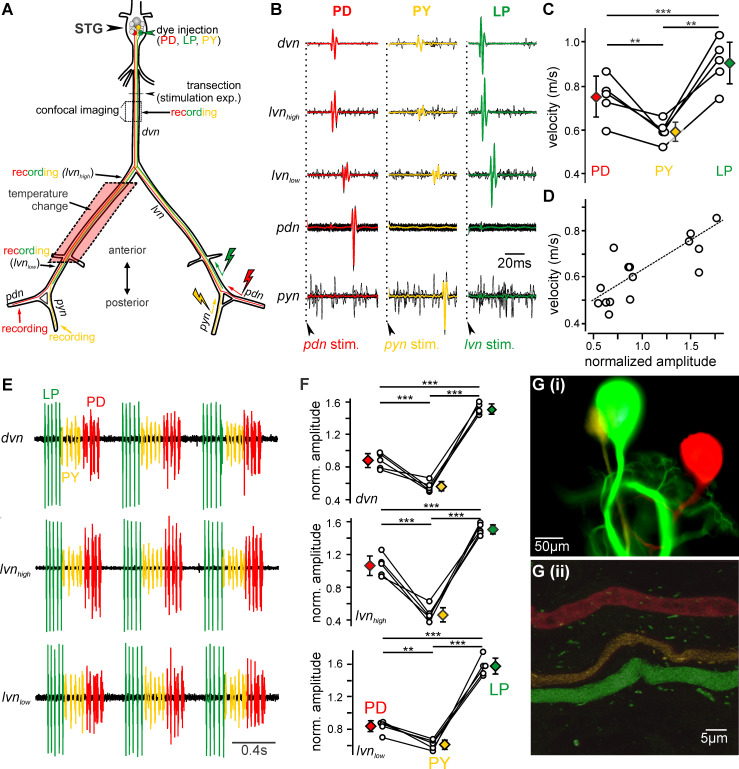
Pyloric axons propagate APs at different velocities.(A) Schematic of the stomatogastric nervous system. Nerve names are italicized. The somata and axons of the PD (red), LP (green), and PY (yellow) neurons are depicted in the color with which they were iontophoretically injected. The dotted box indicates where they were imaged. In some experiments, the dvn was transected, and antidromic APs were elicited in PD, LP, and PY neurons through selective stimulation of the pdn, lvn, or pyn, respectively, on one side of the nervous system (stimulation arrows) and propagated APs were recorded contralaterally. Colors indicate which neurons were detected on a given recording. In selected experiments, temperature was manipulated on parts of the lvn by bathing the nerve in temperature-controlled saline (red box). Nerves: dvn, dorsal ventricular nerve; lvn, lateral ventricular nerve; pdn, pyloric dilator nerve; pyn, pyloric constrictor nerve. (B) Overlay and average of multiple PD, PY and LP APs propagating after stimulation of the pdn, pyn, or lvn (as shown in A), confirming selective activation of individual APs in only one axon at a time. (C) At the control temperature (10°C), the pyloric axons propagate APs at significantly different velocities. (D) Propagation velocity correlates with normalized lvnlow extracellular waveform amplitude. Amplitudes were normalized as in F. (E) Example recordings of three cycles of the pyloric rhythm from multiple locations along the dvn and lvn (compare to A) show that the extracellular AP waveform amplitudes consistently differed between neuron types. (F) Extracellular waveform amplitudes were normalized to the average amplitude of all three neurons in each experiment for comparison across animals. The normalized waveform amplitudes differed significantly from one another at all three locations. Open circles represent the waveform amplitude from a single animal. Colored diamonds represent the average for each neuron type. ** p<0.01, *** p<0.001. (G) Example image of the stained somata of the pyloric neurons (i) and maximum projection from confocal microscopy imaging used to measure axon diameter (ii).